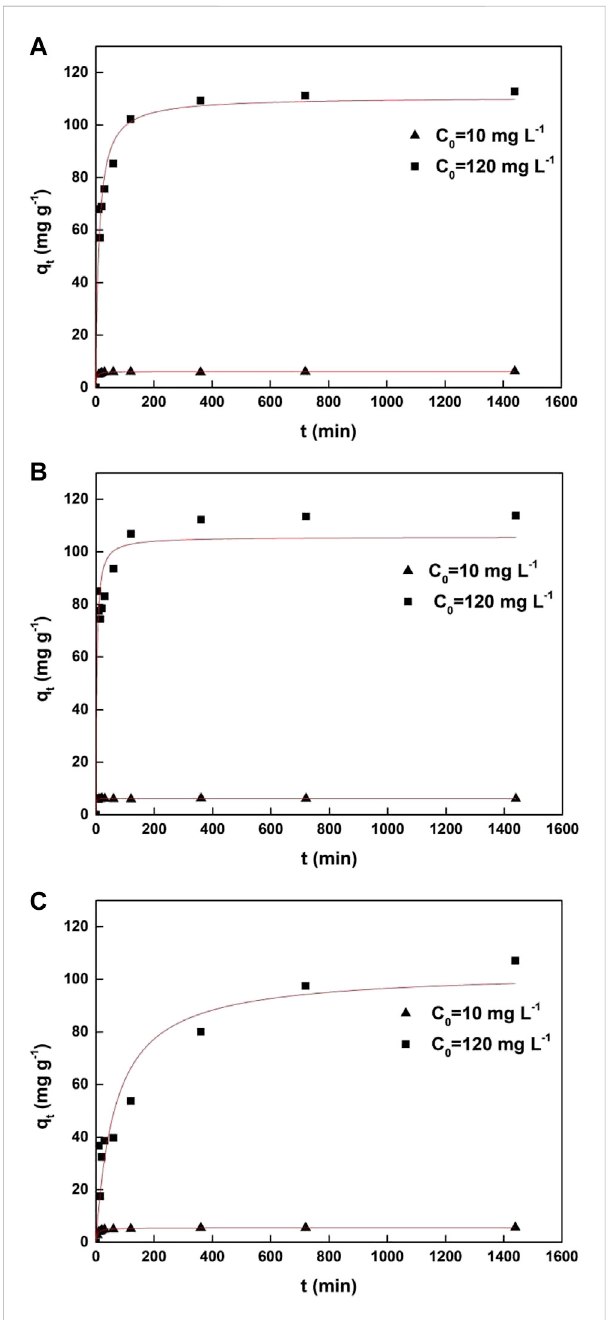
FIGURE 3 Pseudo-second-order kinetic models of non-linear fi tting for Cd(II) adsorption by non-living marine diatom biomass. (A) Chaetoceros sp., (B) Nitzschia sp., and (C) Thalassiosira